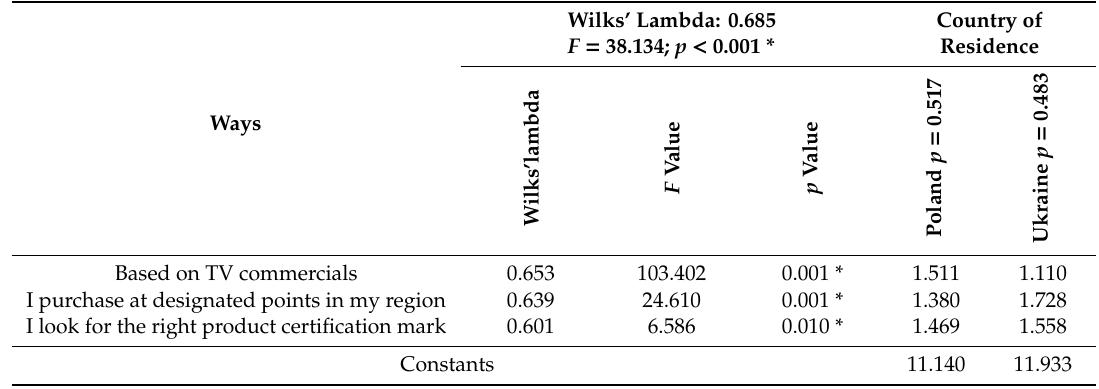
Table 1. Ways of distinguishing regional food products from conventional products.